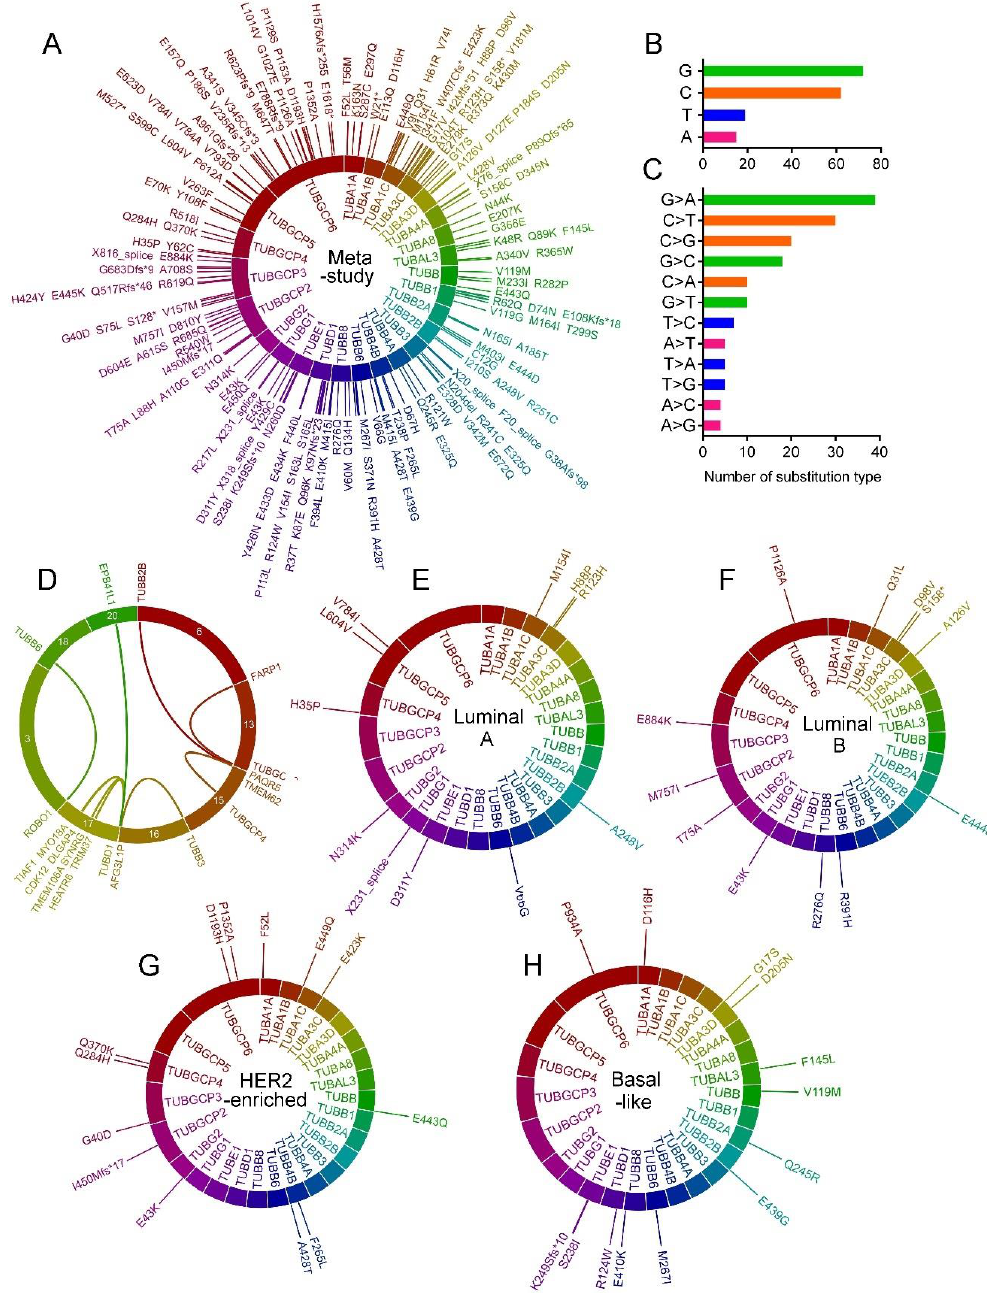
Figure 3. Tubulin gene mutations in BC tumor samples. ( A ) Circle plot of single nucleotide mutations of tubulin isoforms in meta-study BC tumor samples from 4205 BC patients. Layers from inner to outer: gene symbol, scale bars representing protein length, mark bars illustrating the position of mutation, amino acid change mutation identifier. ( B ) The frequency of each mutated nucleotide and ( C ) the type of substitutions. ( D ) Circle plot of tubulin gene fusions. Layers from inner to outer: connection lines illustrating fusions, scale bars representing chromosomes, the fused genes symbols. ( E ) Circle plot of single nucleotide mutations in luminal A, ( F ) luminal B, ( G ) HER2-enriched and ( H ) basal-like BC tumor samples from TCGA, Cell 2015 and TCGA, Nature 2012 studies.